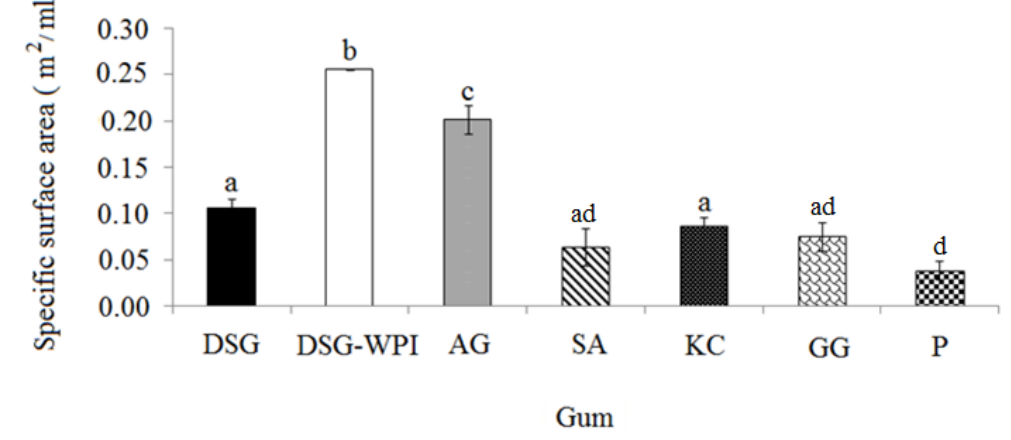
Figure 5. Specific surface area of the non-conjugated durian seed gum (DSG) and conjugated durian seed gum (DSG-WPI) as compared to other commercial gums ( i.e. , Arabic gum (AG), sodium alginate (SA), kappa carrageenan (KC), guar gum (GG), and pectin (P); a – d : significant different at p <